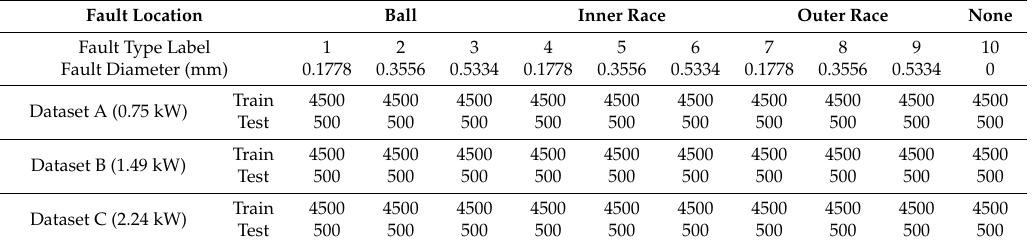
Table 2. Description of experimental data set (the numbers 1 to 10 of Fault Type Label represent the 10 states of the bearing, including nine fault states and one normal state).